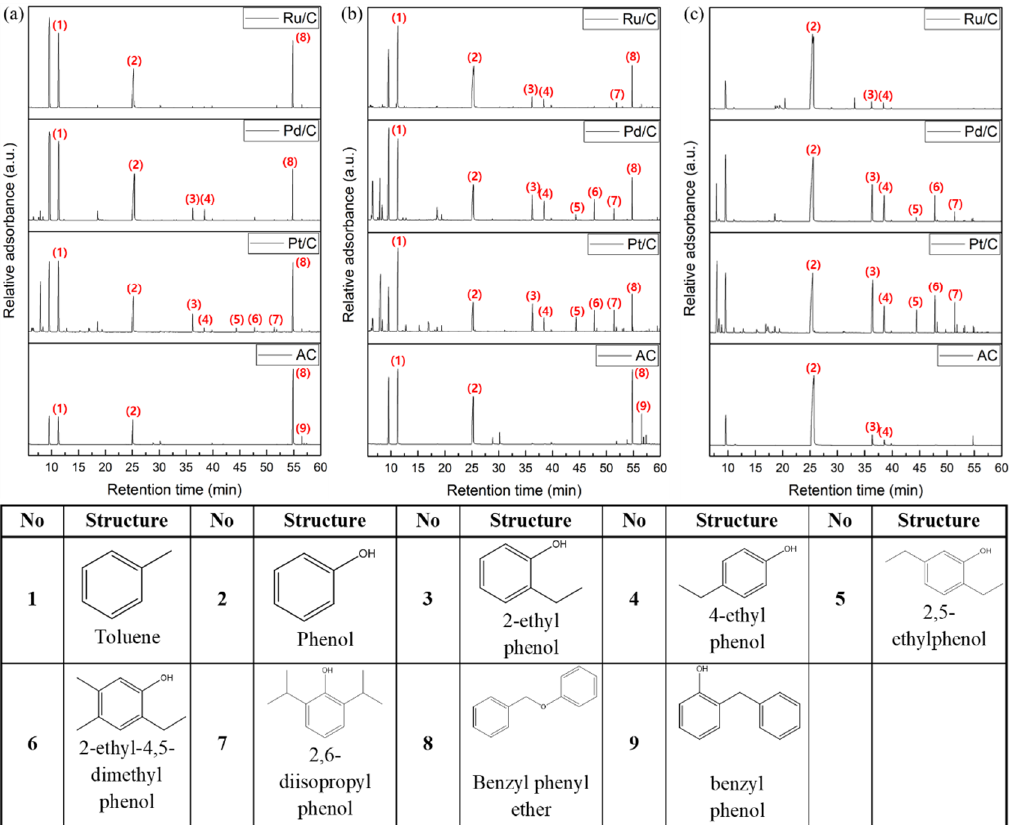
Figure 4. The GC-MS chromatograms of aromatic compounds produced from lignin-related model compounds decomposition over the catalysts at 270 °C in supercritical ethanol. Reaction ( a ) of BPE for 0.5 h, ( b ) of BPE for 4 h, and ( c ) of phenol for 2 h.